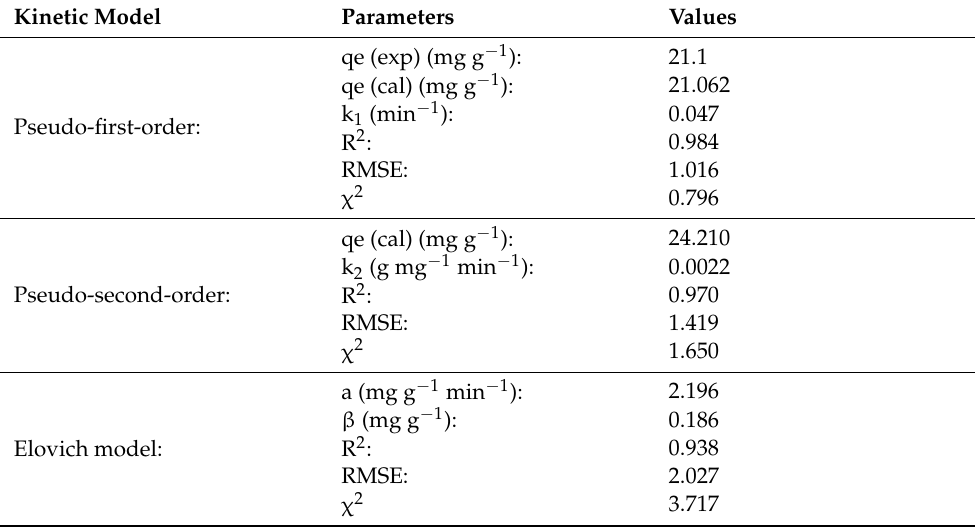
Table 1. Adsorption kinetics parameters for Br − onto GO/PANI@GTW.